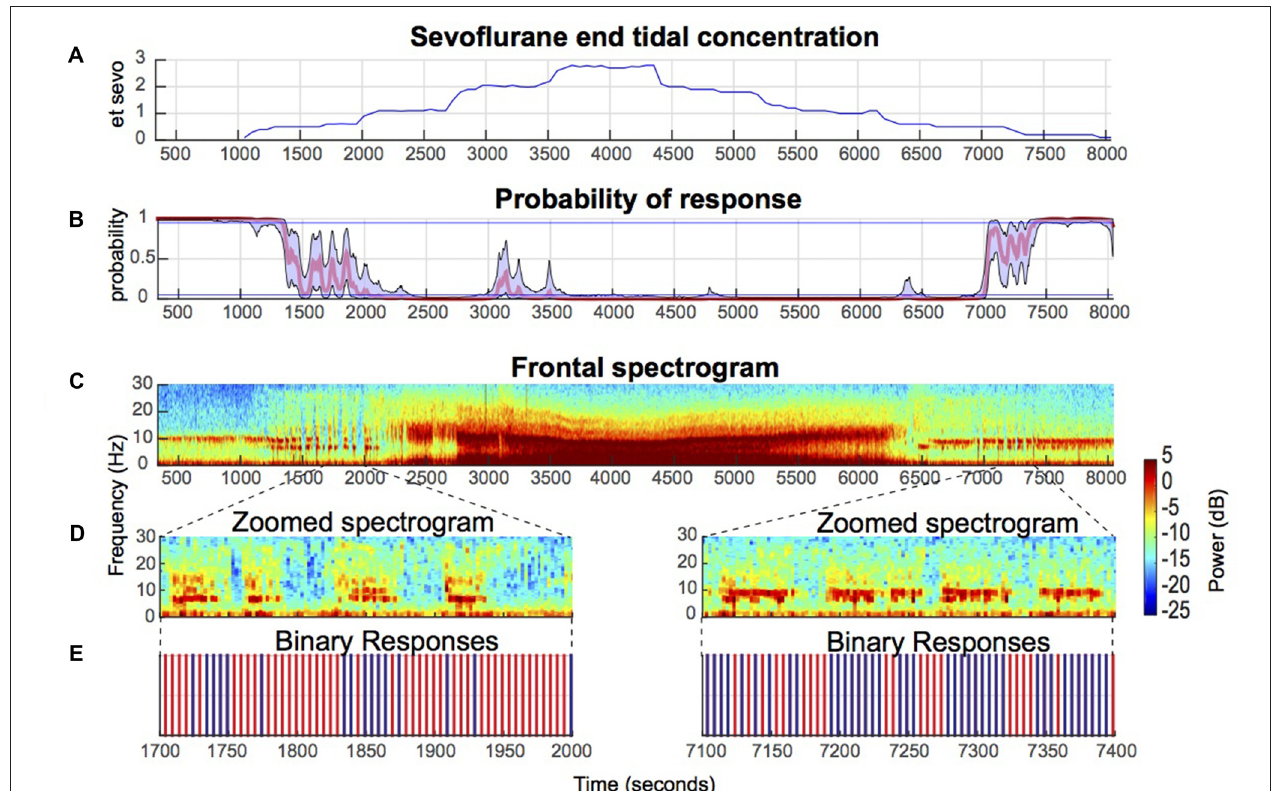
FIGURE 1 | Illustrative electroencephalogram (EEG) spectrogram of a healthy volunteer during induction and emergence from sevoflurane-induced unconsciousness. (A) End tidal sevoflurane concentration during induction and emergence. (B) Behavioral stimuli response-probability curve corresponding to (A) . (C) EEG spectrograms from a frontal channel (approximately Fz) corresponding to (A,B) above show that sevoflurane-induced oscillatory dynamics are closely associated with altered arousal. (D) Zoomed in spectrogram during effect-onset and -offset. (E) Binary response demonstrates that loss of awake-alpha is correlated with lack of response (red) to behavioral